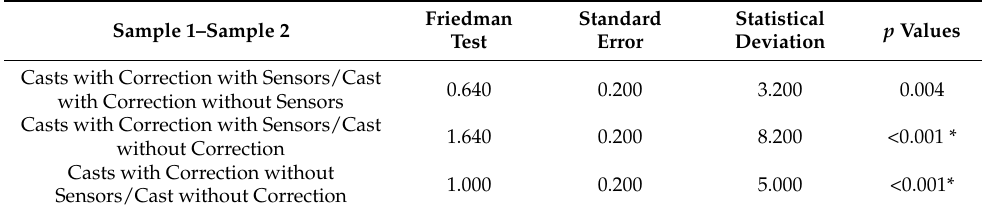
Table 3. “Symmetry Index” variable compared by pairs for the three groups.